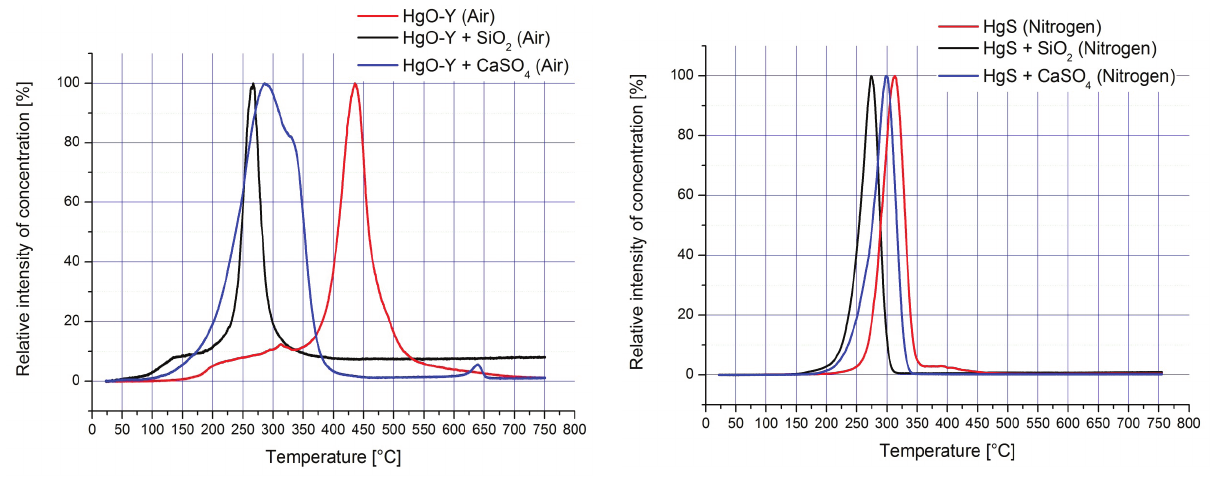
Figure 12: Thermograms of yellow HgO, purged with air.